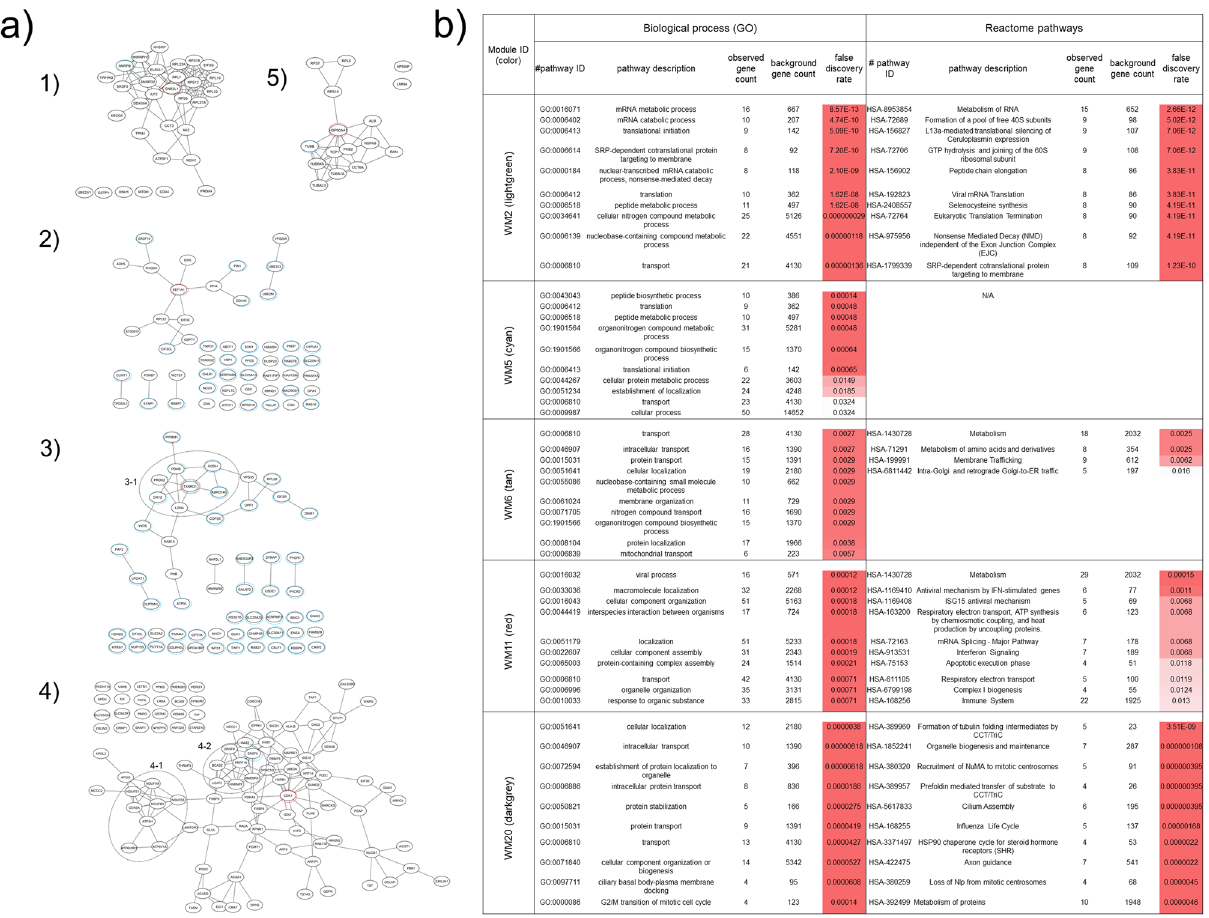
Figure 3. Data-driven protein co-expression networks and pathway enrichment results obtained for the HOT trait. ( a ) The co-expression networks of respective modules: (1) WM2, (2) WM5, (3) WM6, (4) WM11, and (5) WM20 modules. Dotted circle nodes in blue and red represent eigen-proteins and/or hub proteins for the respective module, respectively. ( b ) Top 10 pathways enriched for the protein core networks obtained for biological process (GO) and Reactome